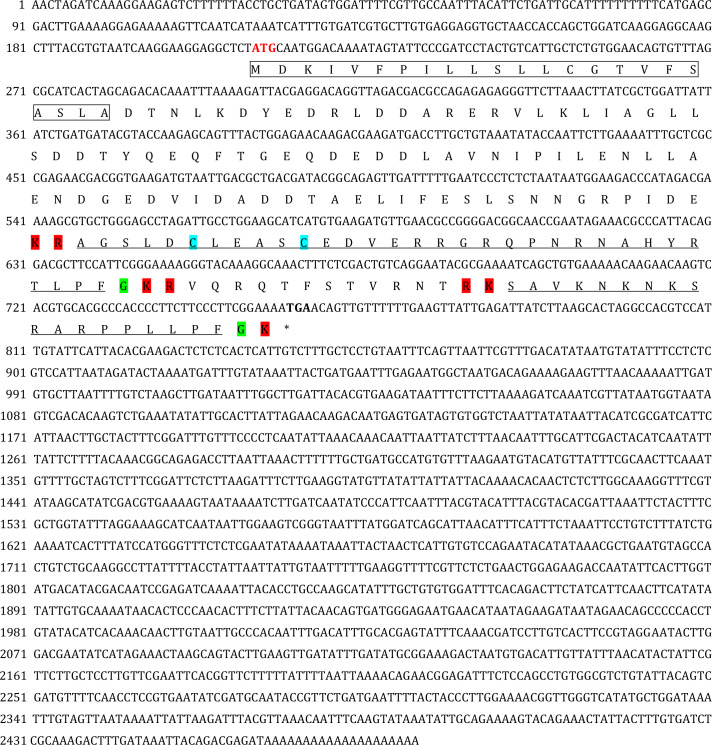
Gene structure of the Apostichopus japonicus kisspeptin precursor.The signal peptide, predicted by the online SignalP-5.0 Server, is labeled in the box; the cleavage sites, predicted on the basis of previously known consensus cleavage motifs using the NeuroPred program, are highlighted in red; the glycine residues responsible for C-terminal amidation are highlighted in green; the cysteines paired in a disulfide-bonding structure are highlighted in light blue; and the predicted mature peptides with C-terminal amidation are underlined in black. The initiation codon (ATG) and the termination codon (TGA) are shown in bold.